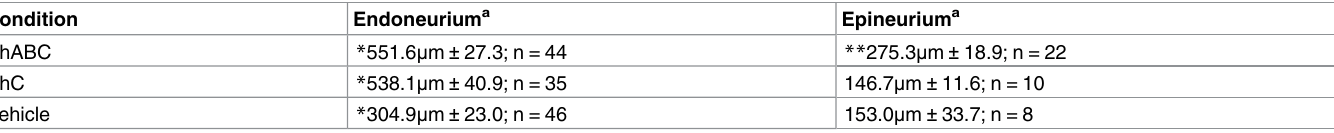
Table 2. Cryoculture